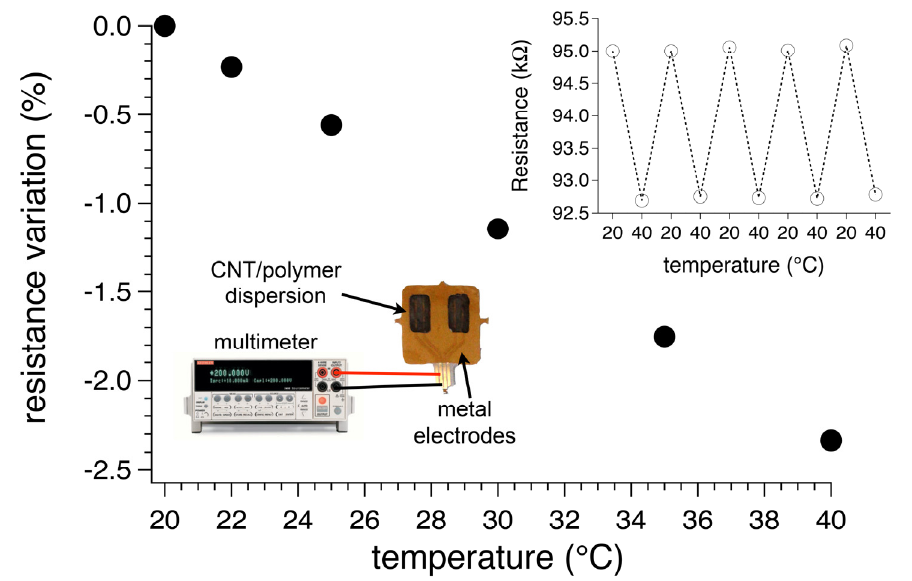
Figure 24. Percentage variation of resistance versus temperature for 13.2 wt% MWCNT/PVBC_Et3N nanocomposites, (inset) experimental set-up and (inset) resistance variation towards alternating heating and cooling cycles between 20 and 40 °C. Adapted from Giuliani et al.